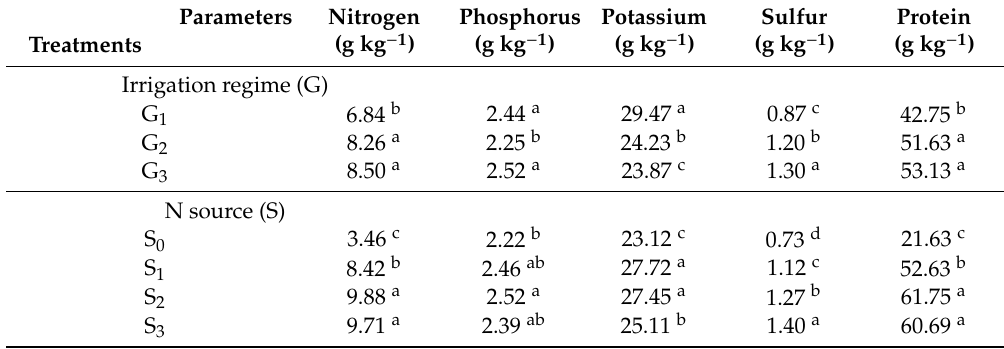
Table 7. Main e ff ects of drip irrigation regime and N source on chemical composition of potato tubers (g kg − 1